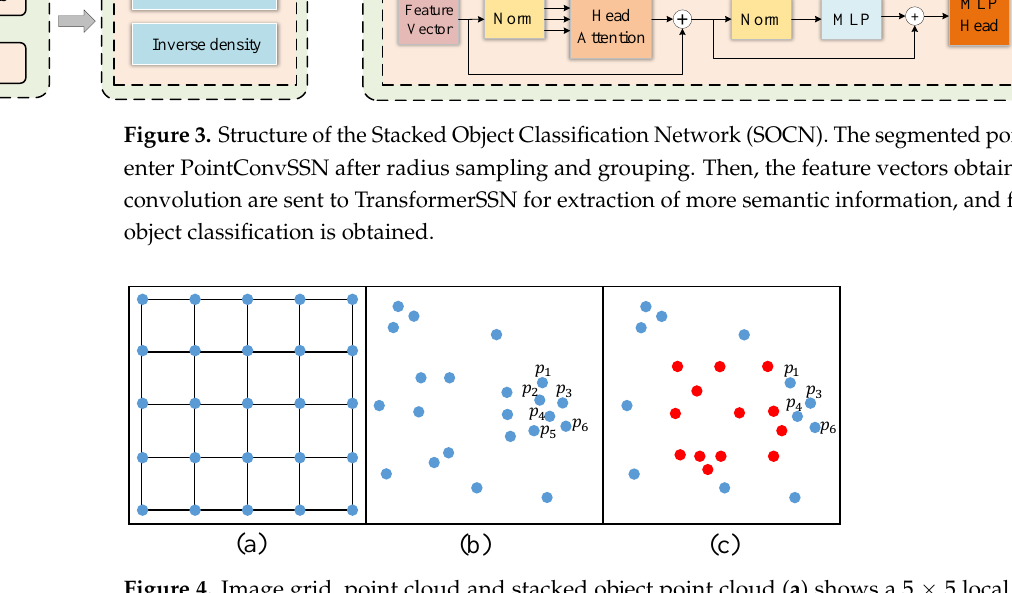
Figure 4. Image grid, point cloud and stacked object point cloud ( a ) shows a 5 × 5 local region in a 2D image, where distance between points are constant; ( b ) shows a local region of a point cloud, the order and relative positions of the points are non-uniform. ( c ) shows a local region of a stacked point cloud. The blue one is obscured by the red